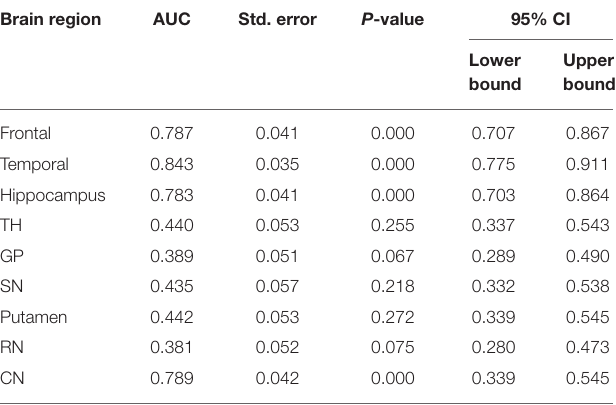
TABLE 4 | ROC curve analysis results of CBF values in brain regions ( n =